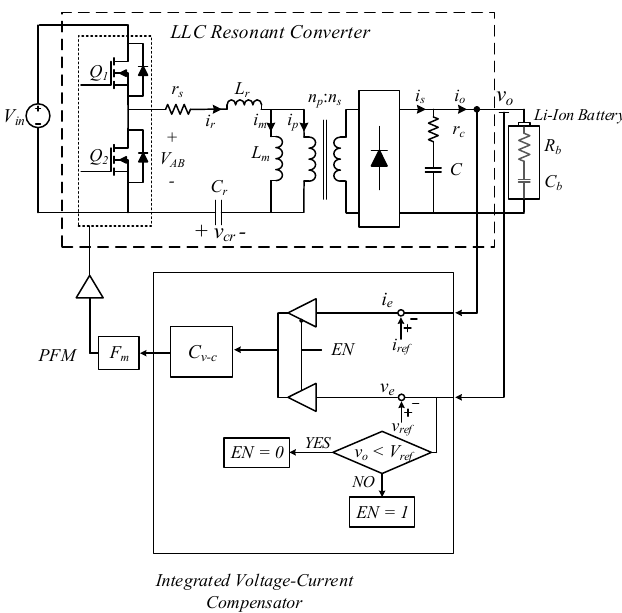
Figure 7. A battery charger including the proposed integrated current-voltage compensator. Energies 2018 , 11 , x FOR PEER REVIEW